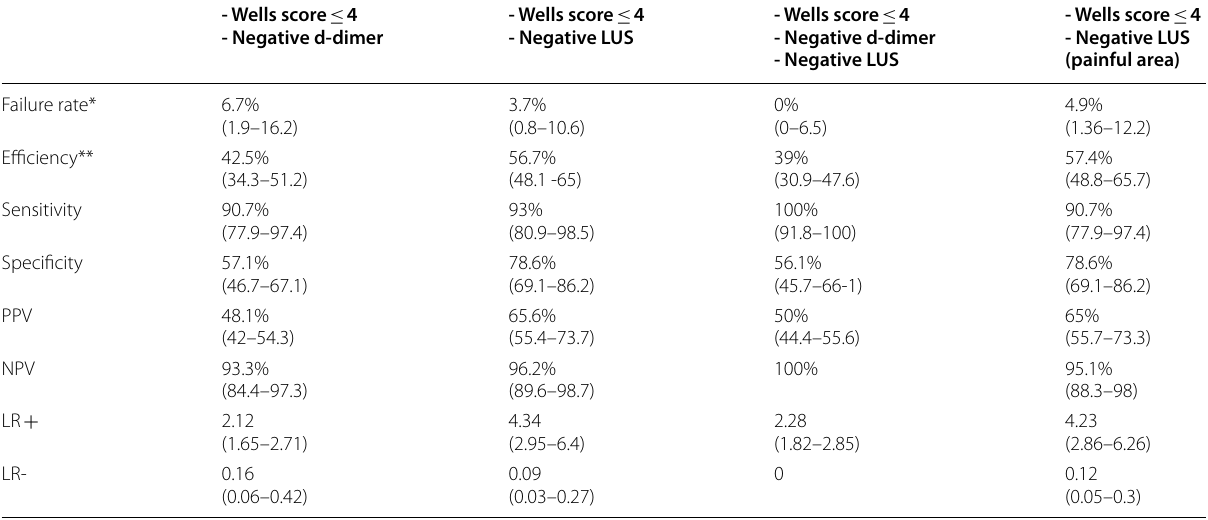
Table 6 Comparison of different diagnostic strategies incorporating Wells score, d-dimer measurement and LUS in 141 patients with pleuritic chest pain and available data on d-dimer, from Reissig 2001 and Nazerian 2017